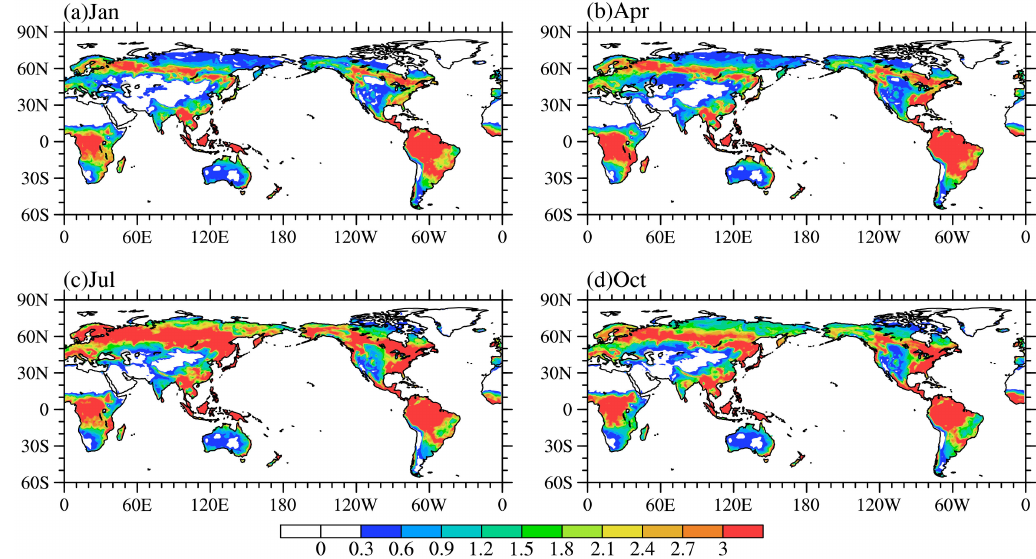
Figure 2. Spatial distribution of the sum of leaf area index and stem area index in January ( a ), April ( b ), July ( c ) and October ( d